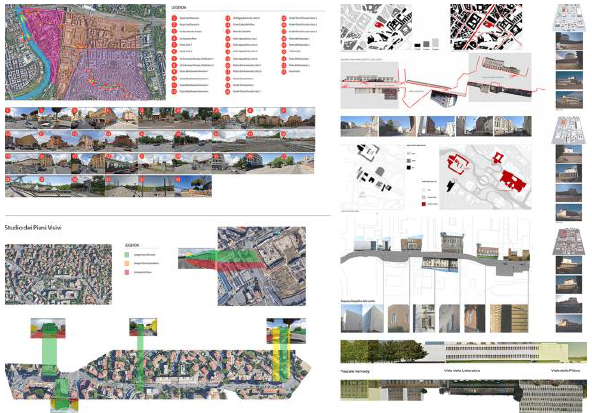
Figure 4 . Rome. Study of visual frameworks for recognisability and identity of places, warm and cold tones.